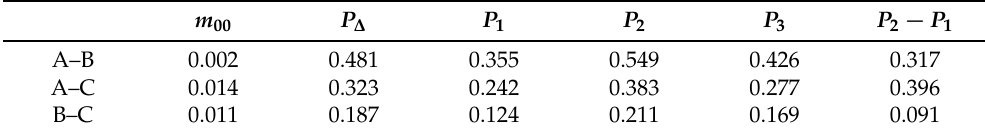
Table 2. Visibility parameters between different objects, i.e., the three selected regions in Figure 5. Here, A is related to the metal coin, B to the plastic coin, and C to the plastic board. m 00 P